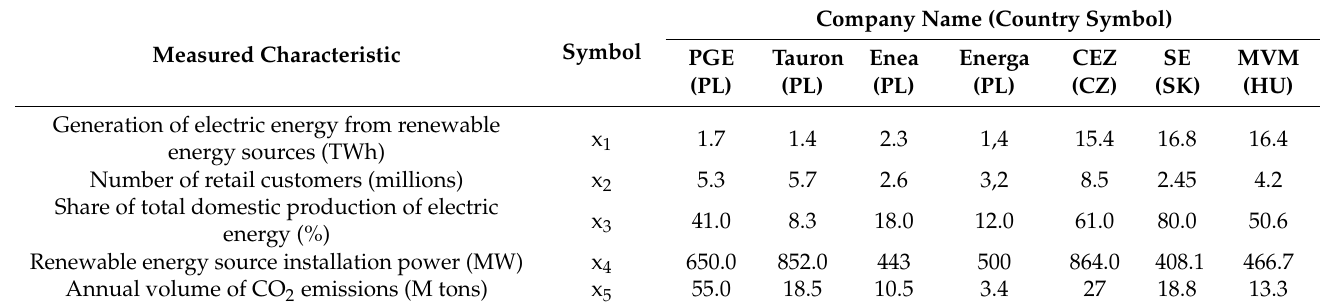
Table 1. Basic indicators for monitoring the sustainability strategy in